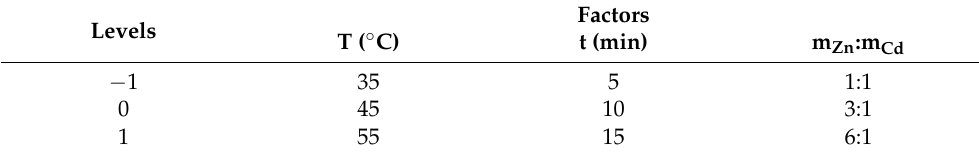
Table 1. Factors and levels of the Cd removal rate optimization experiment.